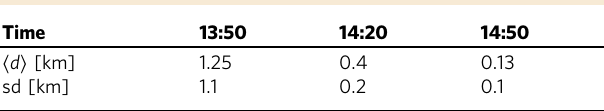
Table 2 2017 fi eld